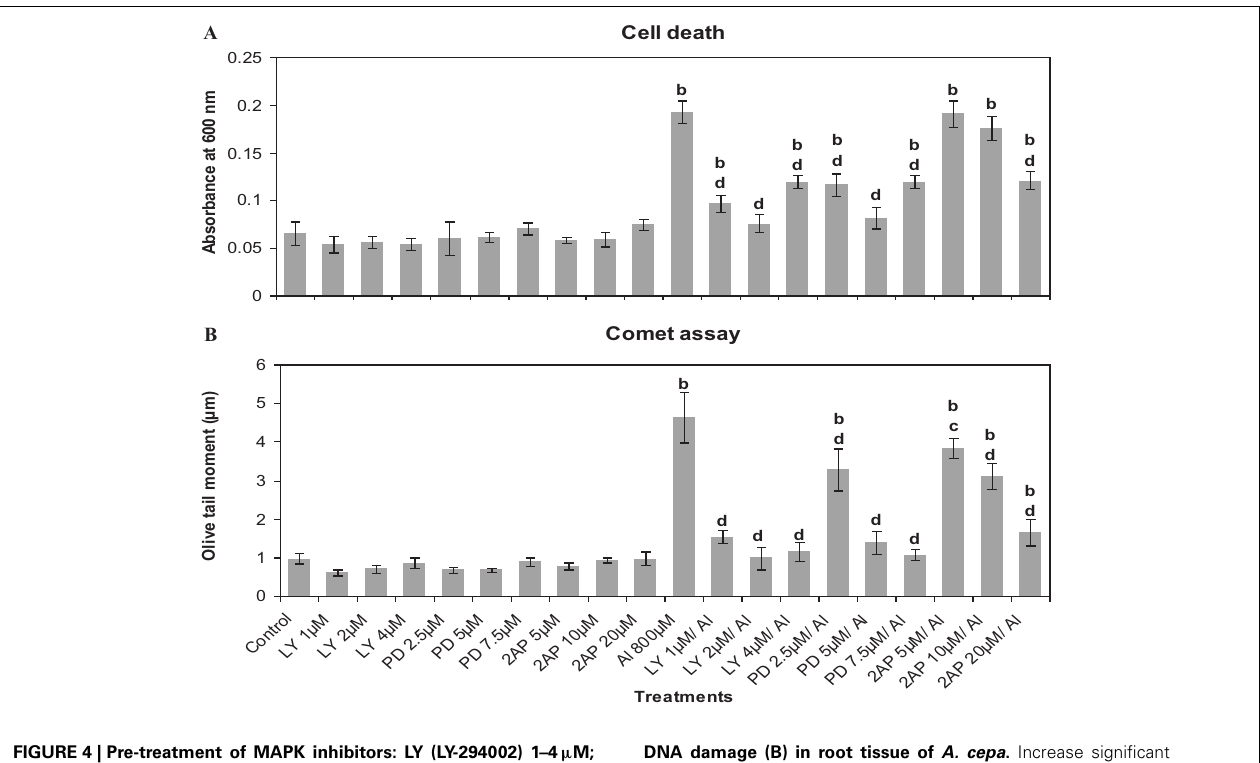
FIGURE 4 | Pre-treatment of MAPK inhibitors: LY (LY-294002) 1–4 µ M; PD (PD-98059) 2.5–7.5 µ M and protein kinase inhibitor: 2AP (2-aminopurine) 5–20 µ M prevented Al 3 + -induced cell death (A) and